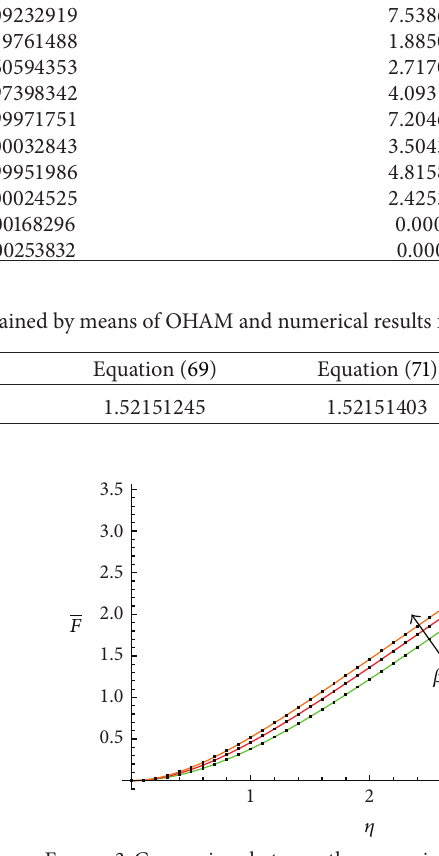
Table 26: Comparison between OHAM results for velocity 𝐹